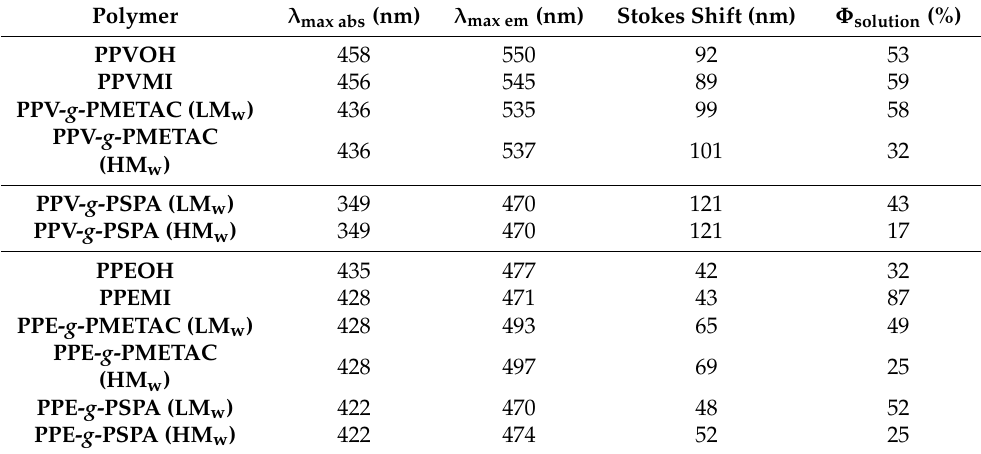
Table 3. Absorption and emission maximum wavelengths, stokes shifts and quantum yields of PPVs and PPEs grafted with ionic PMETAC and PSPA side chains. LM w and HM w designates the graft copolymers formed from the monomer: macroinitiators (PPVMI/PPEMI) ratios of either 250:1 (LM w ) or 500:1 (HM w